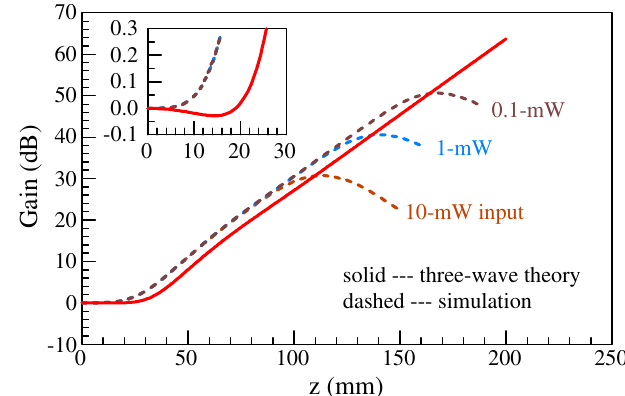
FIG. 4. (Color) Gain profiles from Pierce three-wave linear theory (solid) and particle simulations (dashed) for a 0 : 1 mm (cid:10) 0 : 1 mm beam focused by a 4-kG magnetic field.